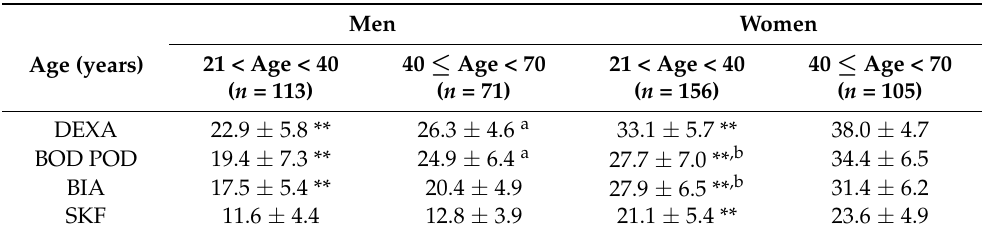
Table 4. Descriptive statistics of PBF separated by age.